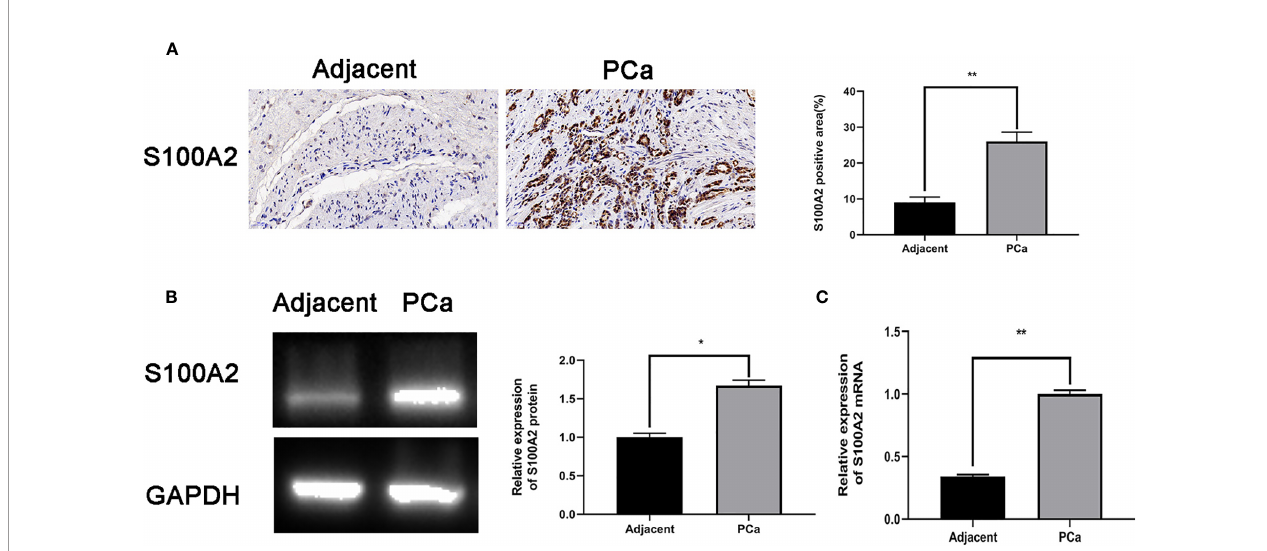
FIGURE 8 | S100A2 validation as a prognostic factor: (A) Immunohistochemistry and quantitative analysis in tumor-adjacent and PCa tissues; (B) S100A2 mRNA expression in tumor-adjacent and PCa tissues; (C) S100A2 protein expression in tumor-adjacent and PCa tissues. * p < 0.05; ** p <